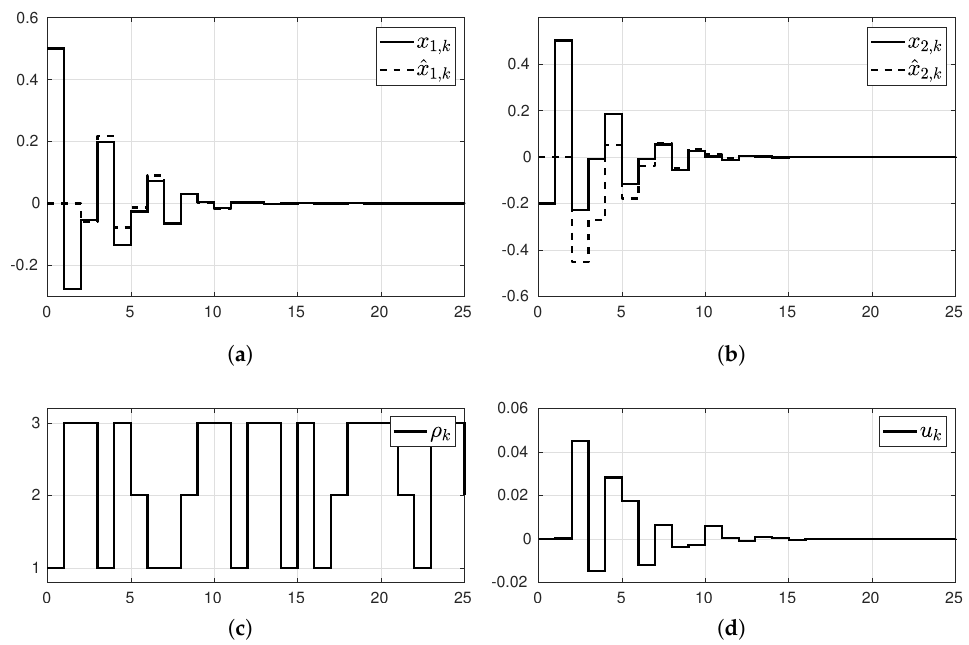
Figure 2. Simulation results of Example 2: ( a , b ) actual and observed states of (38), ( c ) system mode, and ( d ) control